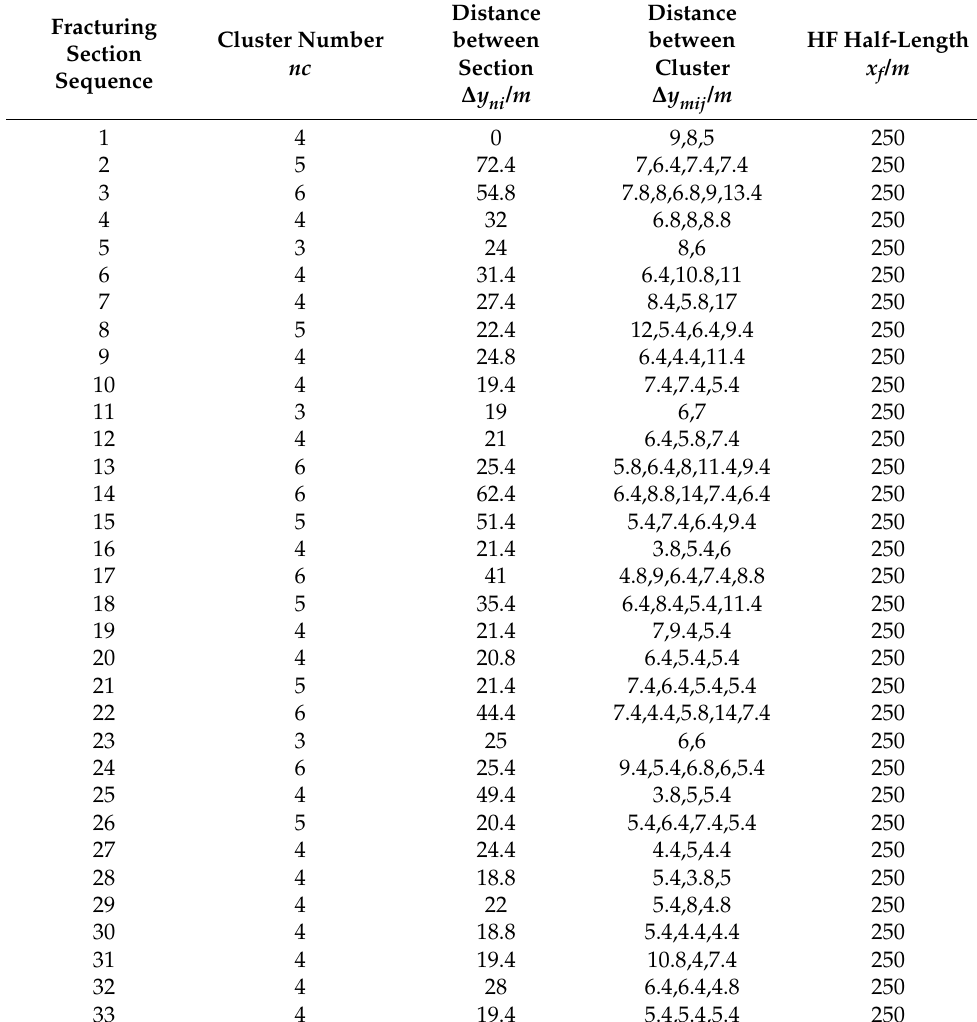
Table 3. Fracture parameters of an oil well in the X